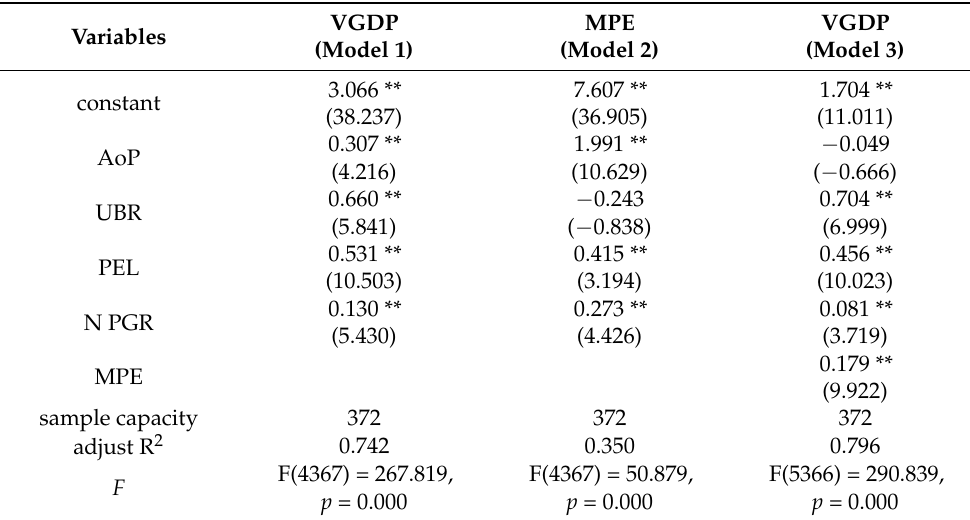
Table 7. Mediating role of health expenditure in the relationship between population aging and economic